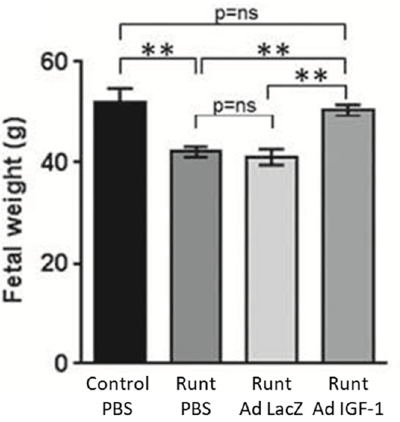
Figure 4. Effect of Ad-IGF-1 gene therapy in a rabbit model of IUGR in which pups at position 3 (Runt) were growth restricted. Ad-IGF-1 treatment significantly increased fetal weight of the